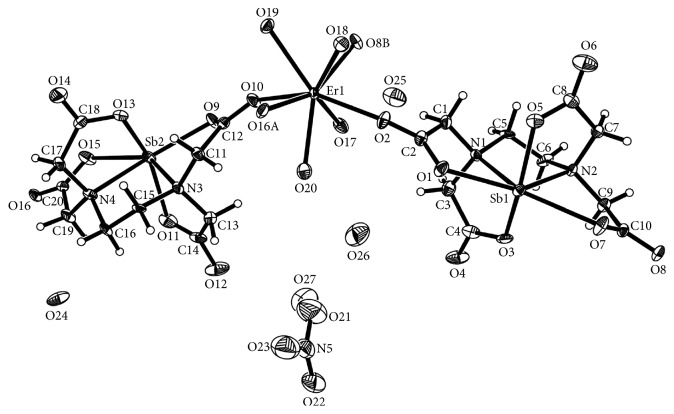
Thermal ellipsoid representation (at 50% probability) of molecular structure unit of the complex. All the H atoms are omitted for clarity. Symmetry codes: A x − 1/2, −y, z − 1/2; B x + 1/2, −y + 1, z − 1/2.